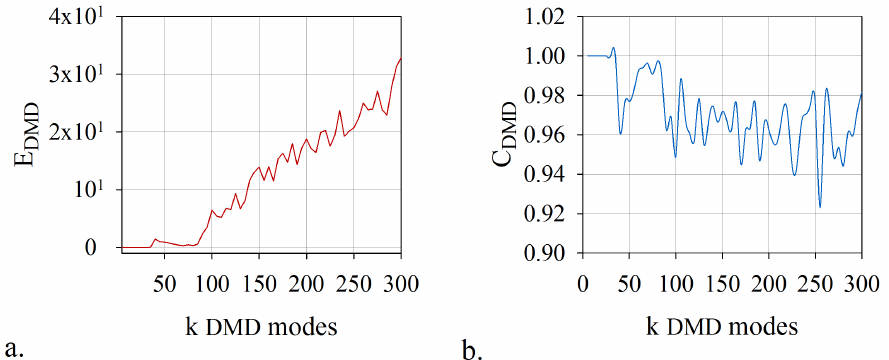
Figure 5. The case Re = 10 3 : ( a ) The relative error computed as a function of retained number of dynamic modes, ( b ) The correlation coefficient computed as a function of retained number of dynamic modes. N DMD = 20 leading modes have been selected.